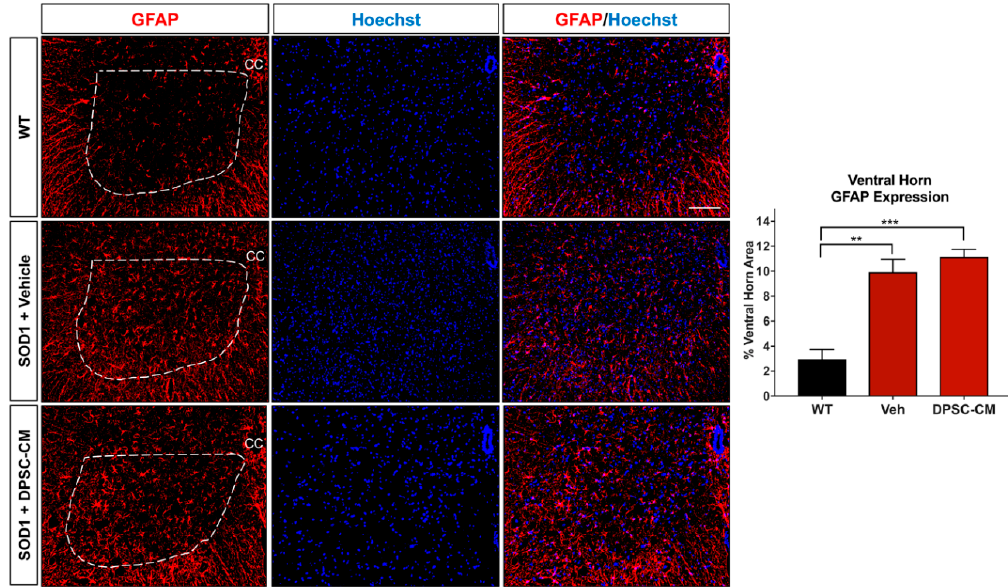
Figure 5. Astrocyte reactivity in the lumbar ventral horn of mSOD1 G93A mice was not significantly affected by late pre-symptomatic DPSC-CM therapy. Assessment of astrocyte reactivity via percent area of the ventral horn (dashed white line) occupied by GFAP+ labeling (red) showed no significant difference between DPSC-CM and vehicle treated mSOD1 G93A mice. Both treatment groups showed similar significant elevation of astrocyte reactivity during this stage of disease compared to WT mice.